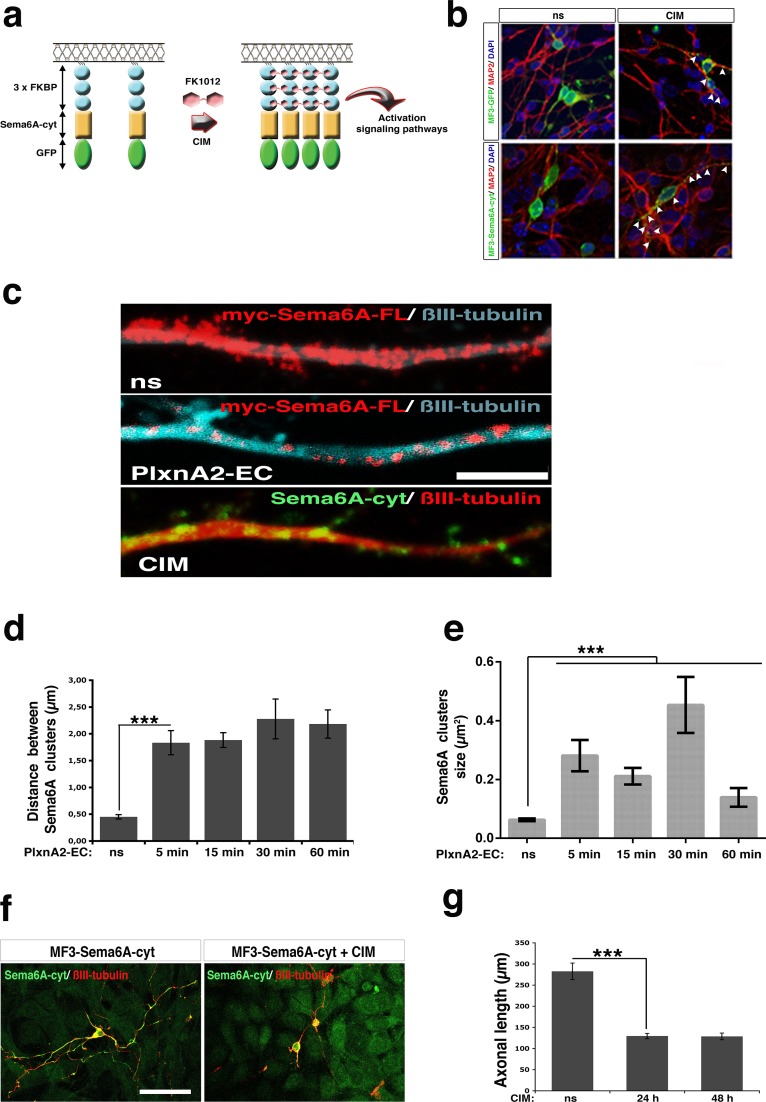
Sema6A reverse signaling is stimulated by multimerisation.(A) Scheme representing how the induced multi-aggregation of the cytosolic domain of Sema6A activates signaling pathways. A chimeric construct was engineered by putting in frame the entire cytosolic domain of Sema6A (Sema6A-cyt) together with 3 self-aggregation FKBP domains, and GFP. The chimeric peptide targets the plasma membrane by the myristoylating sequence located at the N-terminal. The application of the drug FK1012 triggers the chemically induced multimerisation (CIM) of Sema6A-cyt via the self-aggregation of FKBP. (B) Cerebellar neurons transfected with MF3-GFP or MF3-Sema6A-cyt-GFP (MF3-Sema6A-cyt), and treated with 500nM FK1012 (“CIM”). GFP-positive aggregates are indicated (arrowheads). Scale bar = 20μm. (C) Axonal shaft of cerebellar neurons transfected with myc-Sema6A-FL or MF3-Sema6A-cyt-GFP (MF3-Sema6A-cyt), and treated with PlxnA2-EC or CIM respectively. Scale bar = 5 μm. (D) and (E) Graphs summarising the myc-Sema6A-FL aggregation in myc-Sema6A-FL-expressing neurons treated with PlxnA2-EC at different time points. The aggregation is represented as the average distance between Sema6A clusters, or the average size of Sema6A clusters; n = 50–100 cells per time point. Data are expressed as mean ± s.e.m; ***P < 0.001; one-way ANOVA followed by Bonferroni multiple comparison test. (F) MF3-Sema6A-cyt-expressing granular neurons were cultured on NIH3T3 cell layers, and treated with CIM. Scale bar = 50 μm. (G) Graph representing the axonal length of MF3-Sema6A-cyt-expressing cerebellar neurons treated with CIM for 24 and 48h; n = 50–100 cells per experimental condition. Data are expressed as mean ± s.e.m; ***P < 0.001; one-way ANOVA followed by Bonferroni multiple comparison test.